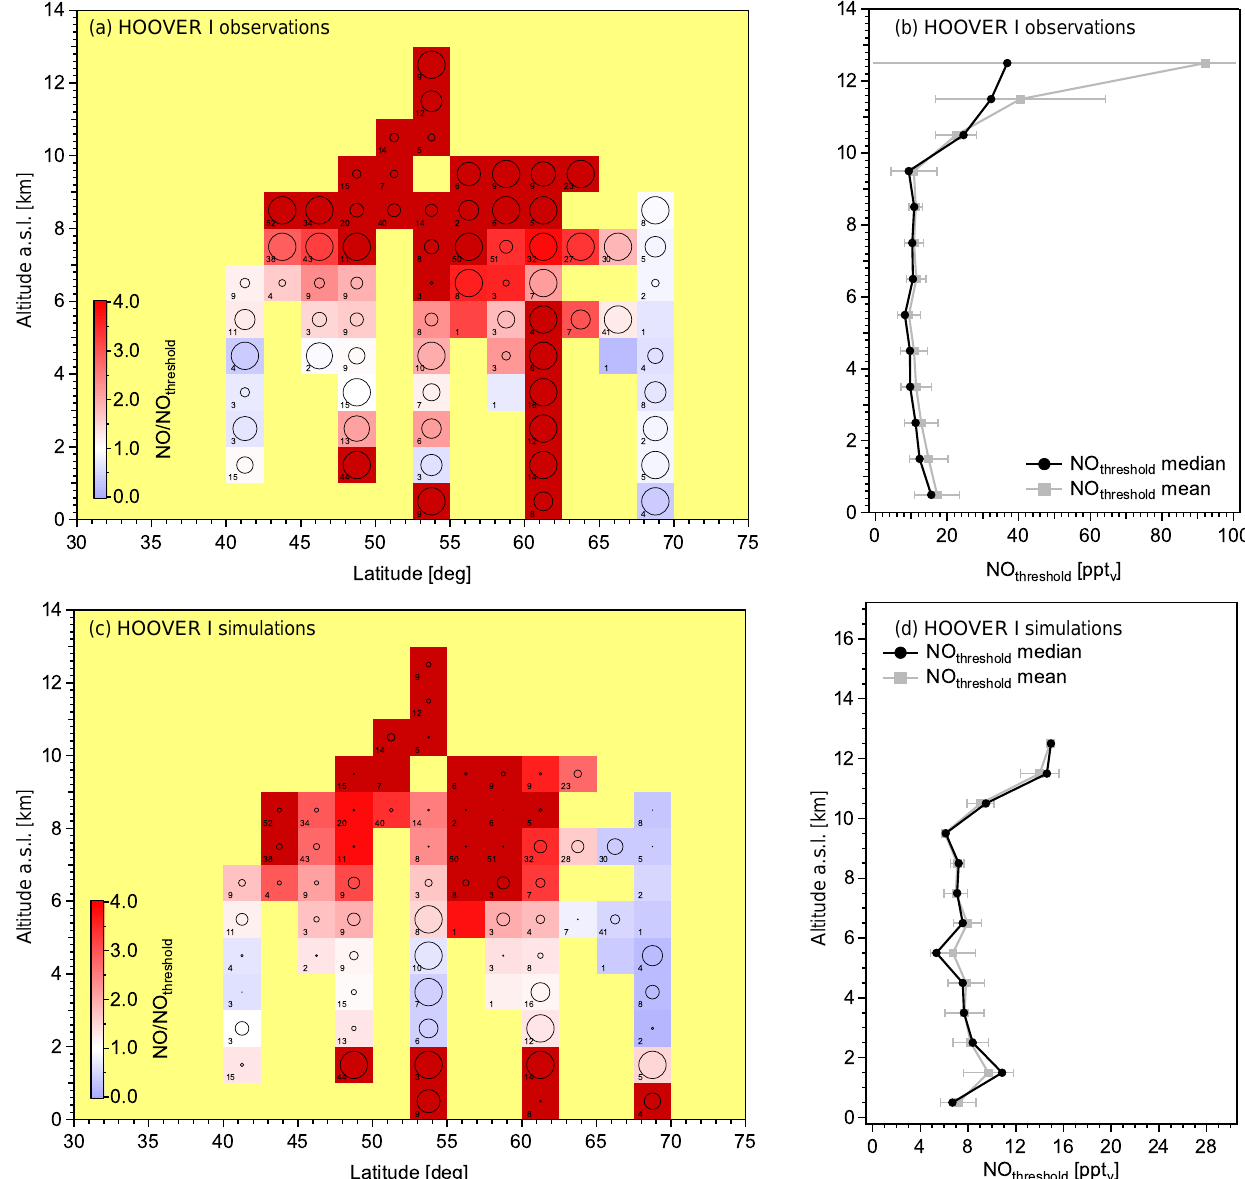
Figure 5. Ratio of NO to NO th deduced from in situ data (a) and MATCH simulations (c) for HOOVER I. Altitude profiles for NO th are given in panel (b) for the observations and in panel (d) for model simulations.